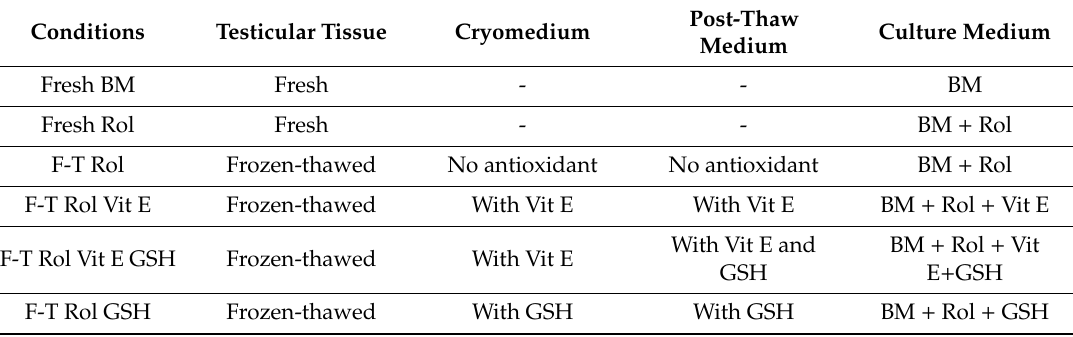
Table 1. Description of the conditions tested according to the in vitro culture procedures of fresh and frozen-thawed prepubertal mouse testicular tissue without or with antioxidant supplementation. (–), absence; ( + ), presence; BM, basal medium; F-T, frozen-thawed; GSH, reduced glutathione; Rol, retinol; Vit E, vitamin E. Conditions Testicular Tissue Cryomedium